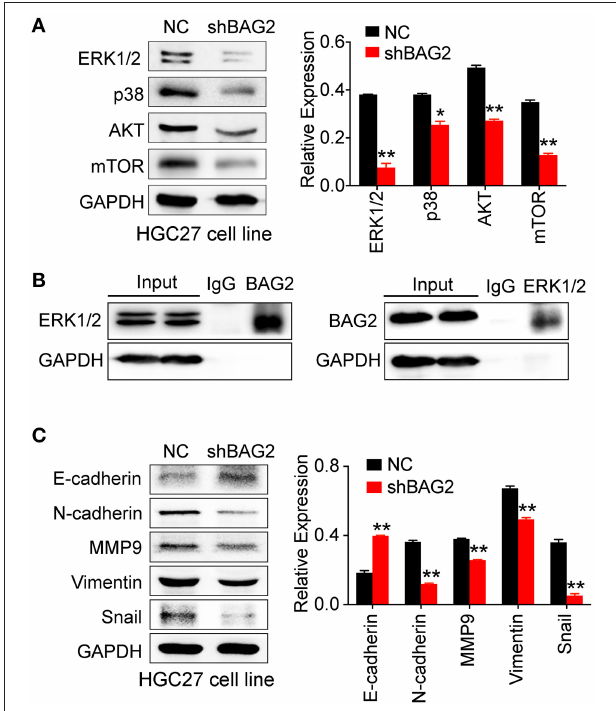
FIGURE 4 | Effects of BAG2 knockdown on AKT/mTOR pathway, ERK pathway, and EMT process. (A) BAG2 knockdown significantly inhibits the expression of AKT, mTOR, p38, ERK1/2; (B) Immunoprecipitation result showed that BAG2 could bind to ERK1/2; (C) BAG2 knockdown significantly up-regulated E-cadherin and inhibited the expression of N-cadherin, MMP9, Vimentin and Snail, which were related to EMT process. * p < 0.05 ; ** p <